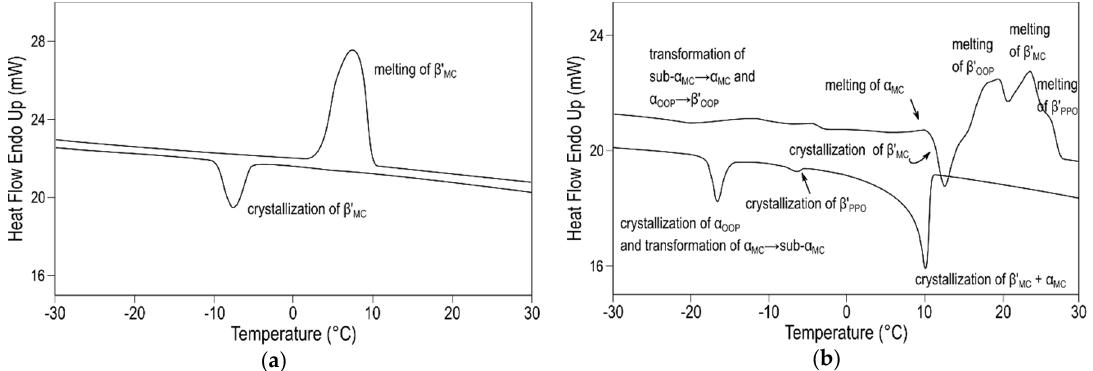
Figure 9. Polymorphic behavior in equimolecular mixtures of ( a ) OPO / OOP during cooling at 0.5 ◦ C · min − 1 and subsequent heating at 2 ◦ C · min − 1 ; and, ( b ) PPO / OOP during cooling and heating at 2 ◦ C · min − 1 . Reprinted with permission from [130], © 2015 American Chemical Society.